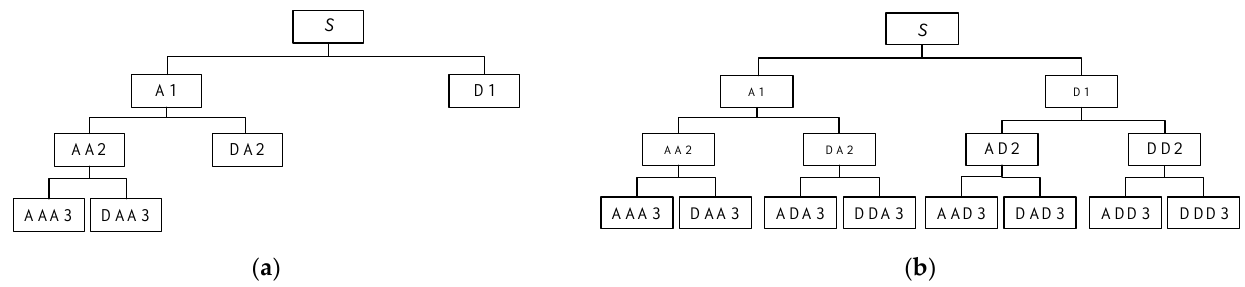
Figure 2. Comparison of wavelet decomposition and wavelet packet decomposition: ( a ) Wavelet decomposition and ( b ) Wavelet packet decomposition.